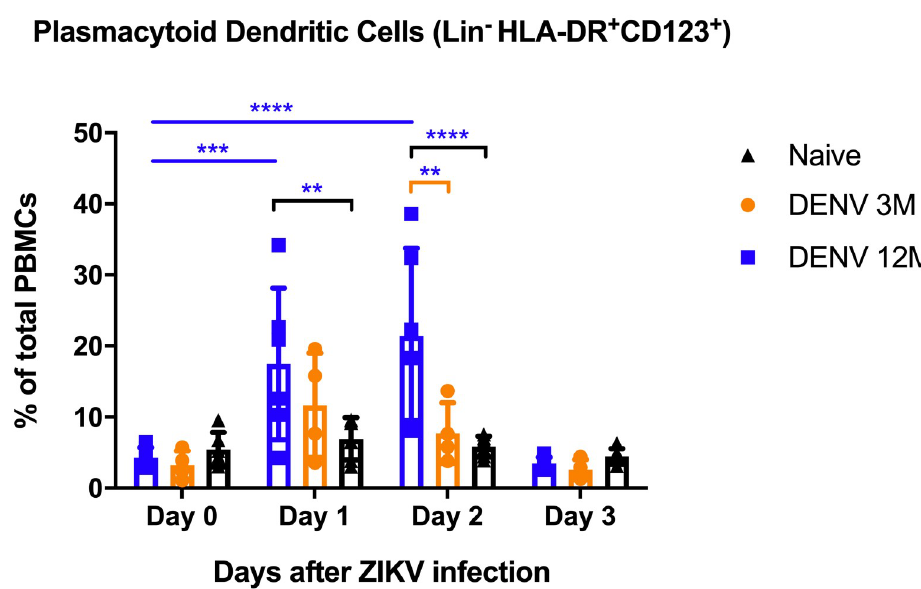
Fig 6. Changes in percentage of plasmacytoid dendritic cells. Percentage of plasmacytoid lineage dendritic cells out of total gated PBMCs. Na ï ve animals are depicted in black. Animals exposed to DENV 12 months before ZIKV infection are in blue, while animals exposed to DENV 3 months before are in orange. Na ï ve animals are in black. Differences amongst cohorts in respect with their baseline values were computed by two-way ANOVA using Tukey’s multiple comparisons test ( �� P < 0.01, ��� P < 0.001 and ���� P < 0.0001). Colored stars represent a significantly different group, while colored lines represent the group that it is compared to. Same colored lines and stars represent a significant difference compared to their